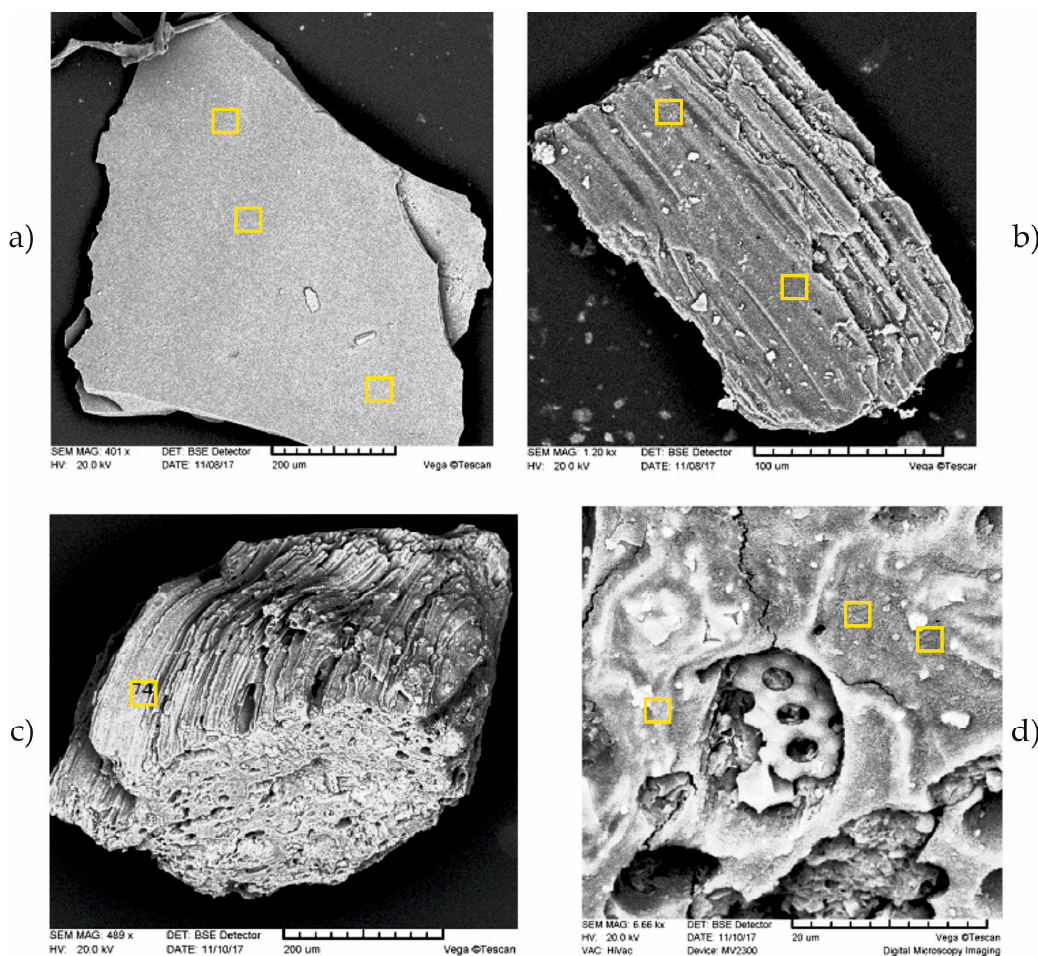
Figure 5. Scanning electron microphotographs of the persilicic ash shards from the core unit of 323–340 cm: ( a ) angular dense greenish transparent glass with a median content of SiO 2 of 76.37% in the sample of 323–325 cm, ( b ) rectangular light semi-transparent dense foliated shard with a SiO2 content of 75.57–76.88% in the sample of 328–3330 cm, ( c ) and ( d ) general view and fragment, respectively, of vesicular, greenish, semi-transparent glass (SiO 2 content of 70.38%) in the sample of 334–336 cm, with layered andesitic insertions (SiO 2 content of 55.90%) and titanomagnetite crystals and fragments of diatom frustules. Yellow-outlined rectangles show points of measurements.